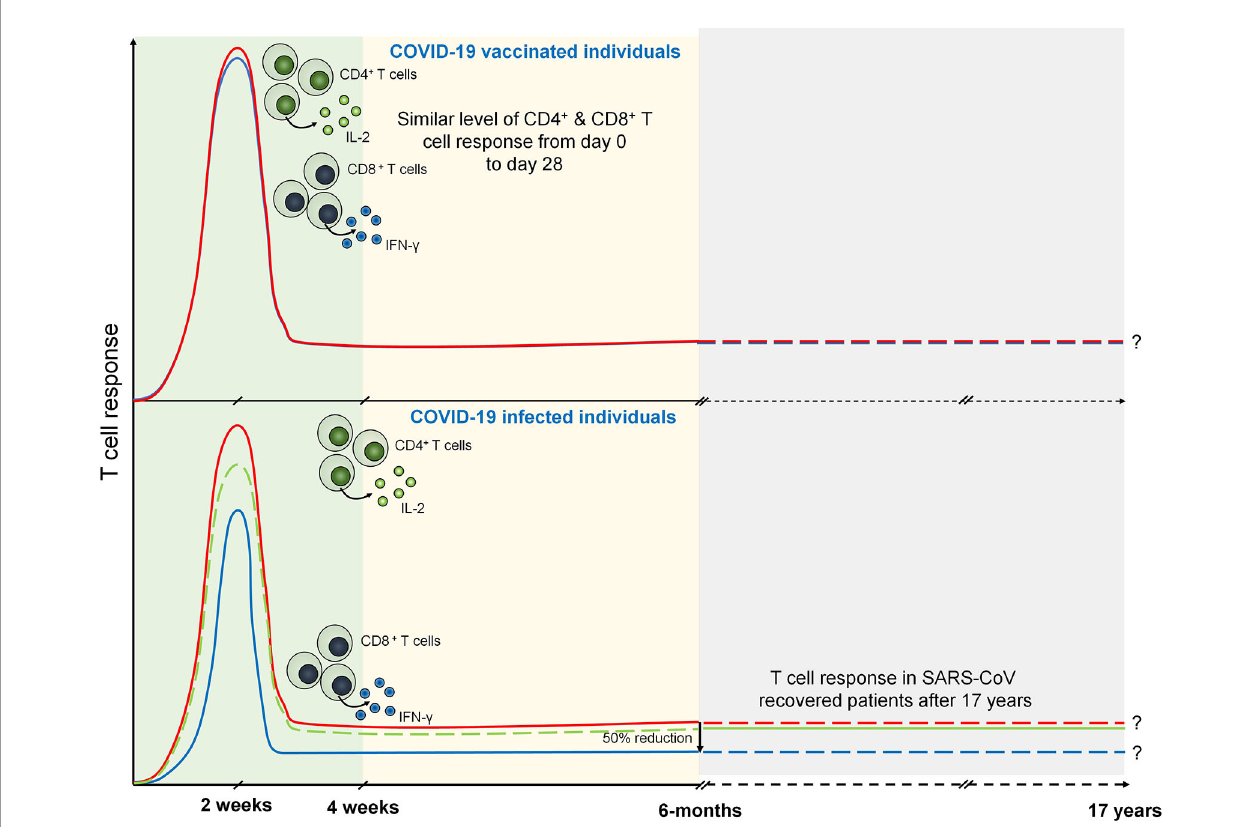
FIGURE 2 | T cell response during COVID-19 and vaccinated individuals. Both CD4 + (marked by IL-2 expression) and CD8 + T (marked by IFN- g expression) cell response are peaked at 14 days from the onset of infection. However, after 6 months of COVID-19 infection CD8 + T cell response becomes half of the CD4 + T cell response. SARS-CoV speci fi c T cell response is seen after 17 years that may suggests the persistence of antigen speci fi c memory T cells. Similarly, T cell response are seen in COVID-19 vaccinated individuals which are prominently observed in day 0 to day